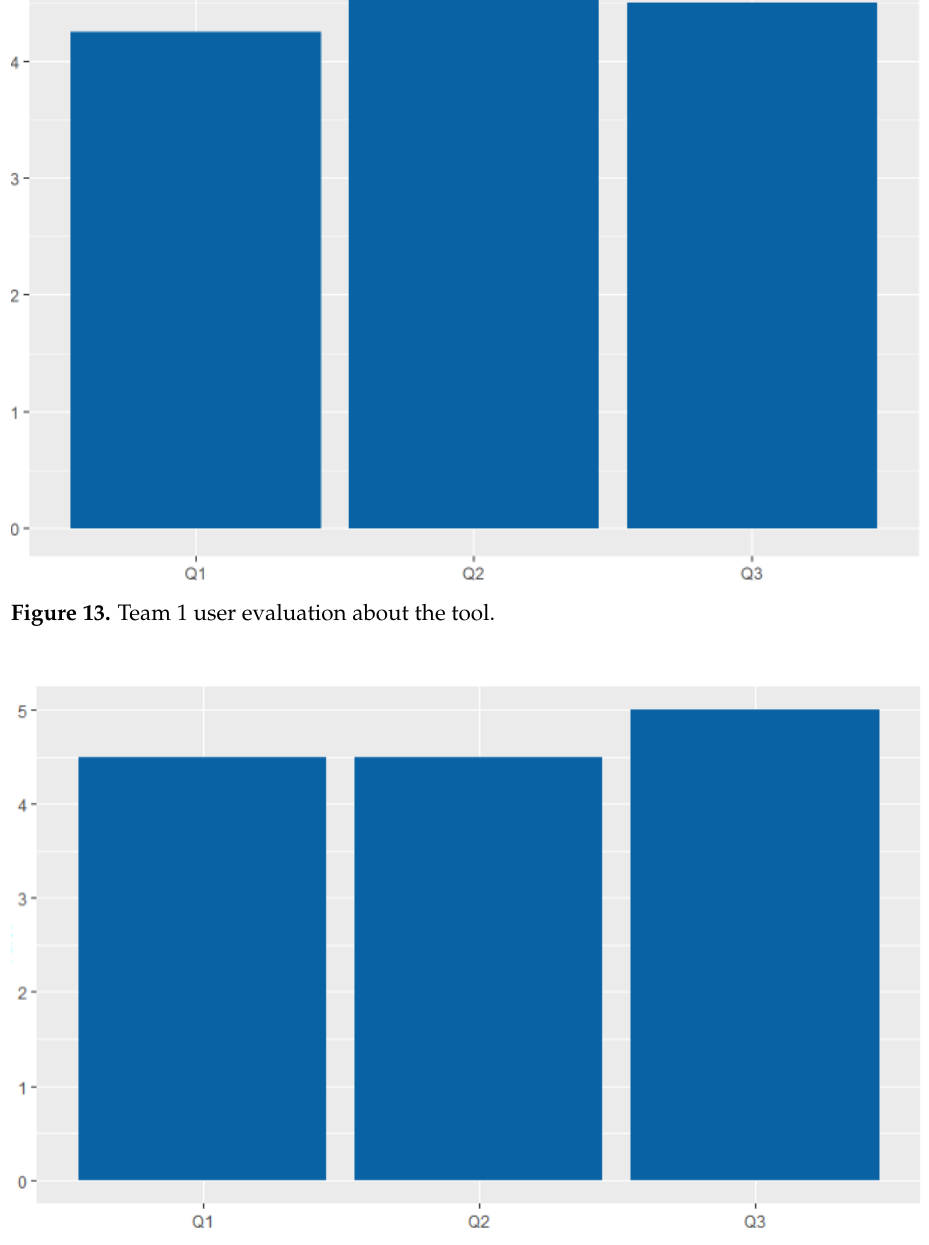
Figure 14. Team 2 user evaluation about the